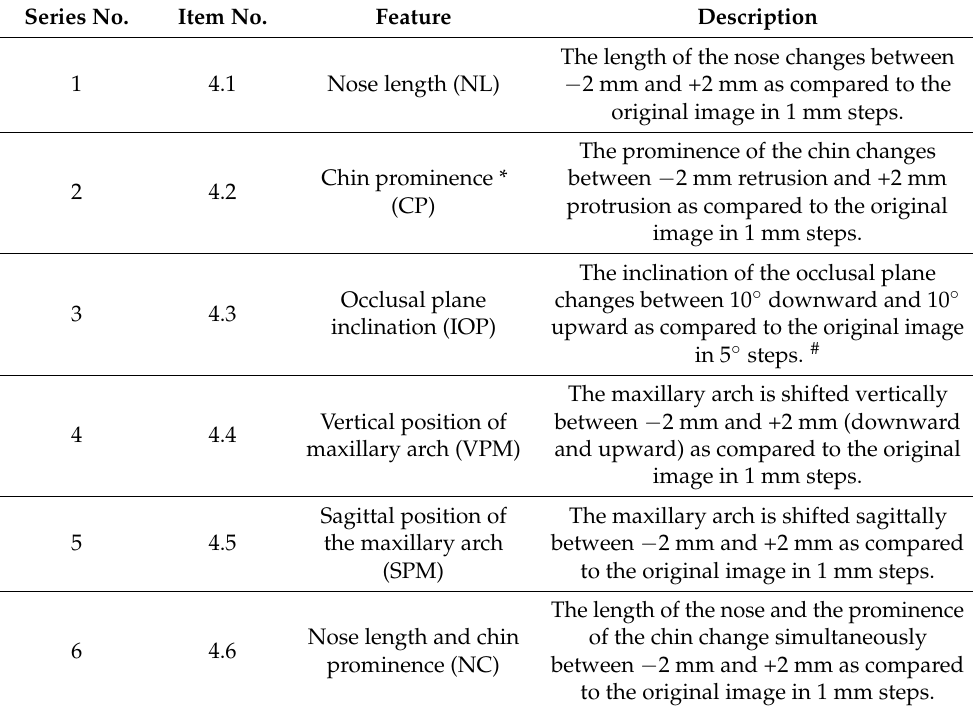
Table 1. Photo rating: the modified profile